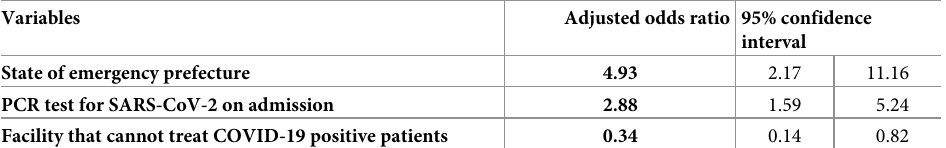
Table 3. Variables associated with community-acquired infection of COVID-19—Result of multivariate logistic regression